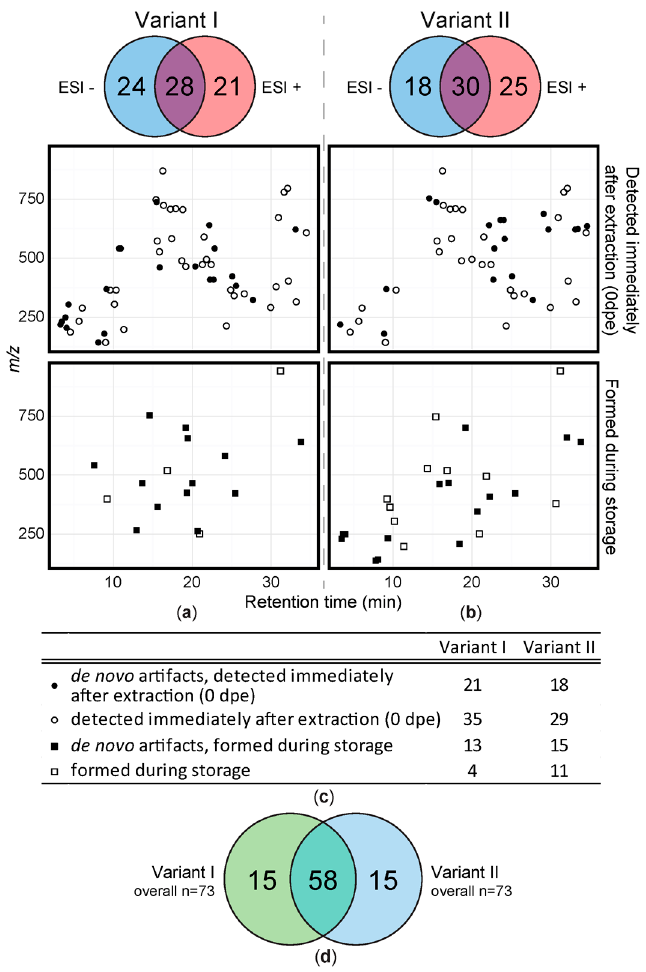
Figure 2. Overview of all detected solvent artifacts. 2D-plots of artifacts detected immediately after extraction and formed during storage. ( a ) acidified extraction mixture and ( b ) extraction mixture without acidification. Black symbols illustrate MeOH derived derivatives that were not present in the original leaf metabolome ( de novo ). White symbols: relative amount changed/increased due to reaction of native wheat constituents during extraction or storage. Circles represent artifacts formed during sample extraction, squares refer to artifacts that were detected during storage for up to 10 days. The Venn diagrams above the 2D-plots show polarity modes, in which respective numbers of artifacts were detected. ( c ) gives an overview of the number of metabolites detected directly after extraction and/or de novo artifacts. ( d ) number of artifact compounds detected in variant I (green) and variant II (blue).